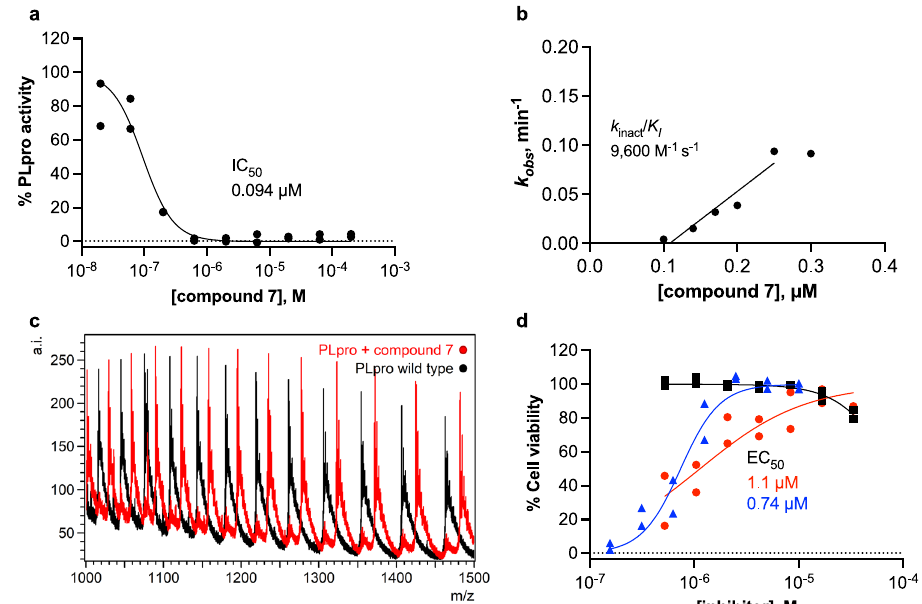
Fig. 5 | Characterization of a designed covalent PLpro inhibitor, compound 7. a Fluorogenic peptide activity assay after 30-min preincubation with compound 7 . Dataareplottedforeachof n =2independentsamples.IC 50 istheconcentrationat which 50% inhibition was observed. Curve is the nonlinear regression to the nor- malizedinhibitordoseresponseequation. b Time-dependentcharacterizationwith a fl uorogenic peptide assay. Data points are k obs values determined by fi tting the exponential decay equation to initial rates determined at various inhibitor con- centrationsandpreincubationtimes,normalizedtonopreincubation. k obs dataare presented as mean values determined from n =2 independent samples. Line